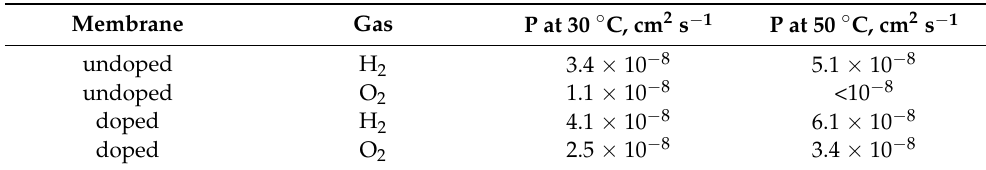
Table 1. Hydrogen and oxygen permeability values at 30 and 50 °C for the membrane doped with phosphoric acid and for the undoped composite membrane.